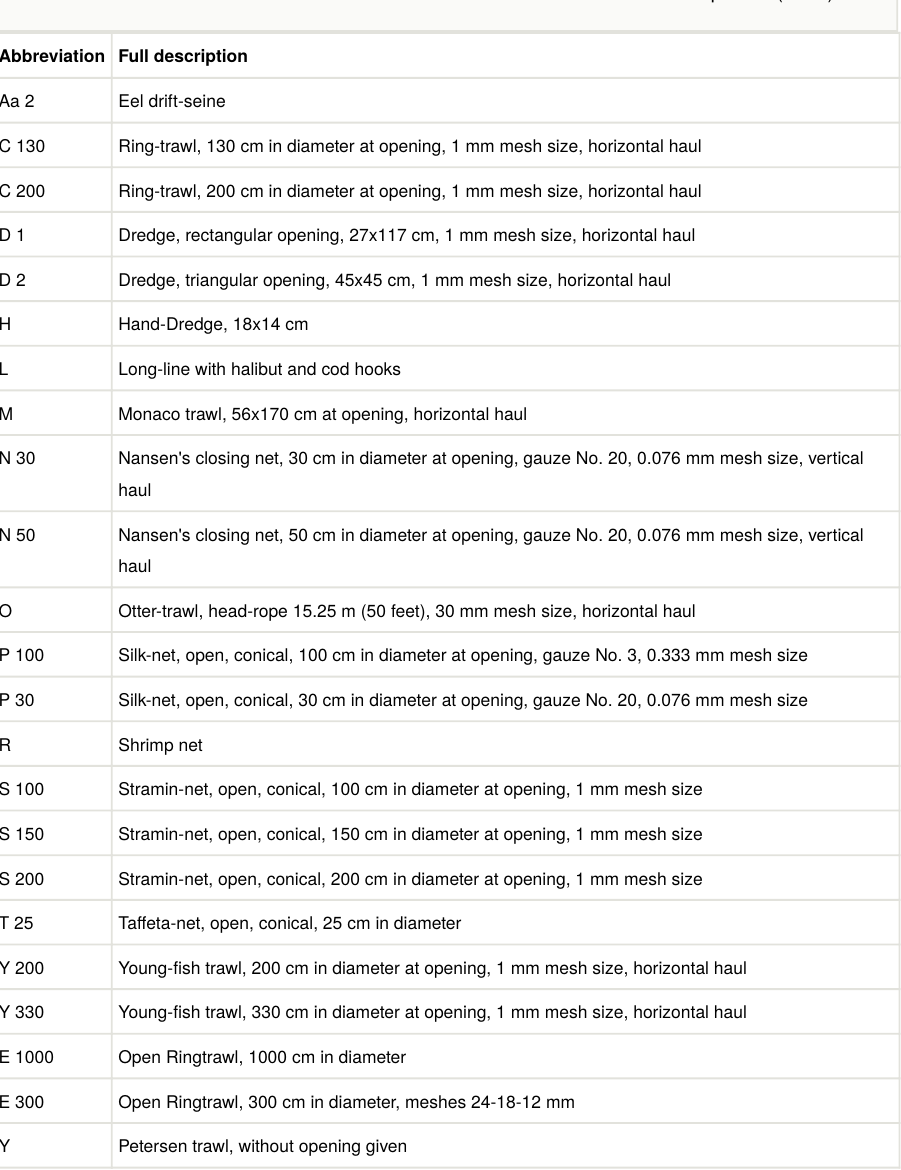
Sampling gears used during the "Thor" (and complementary) expeditions. Abbreviations are